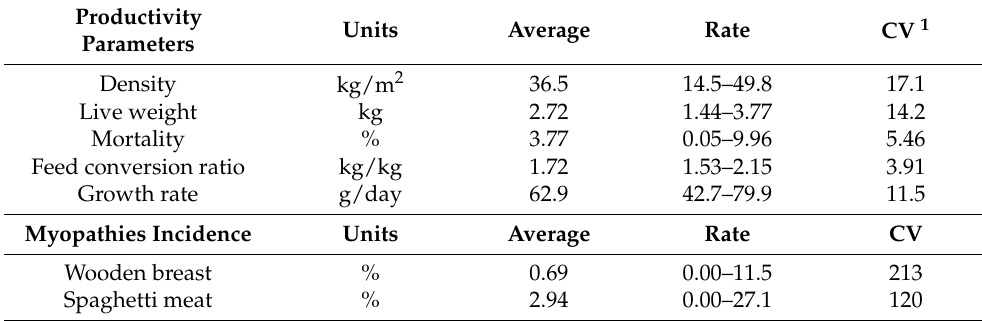
Table 1. Average values and variation in the continuous variables.